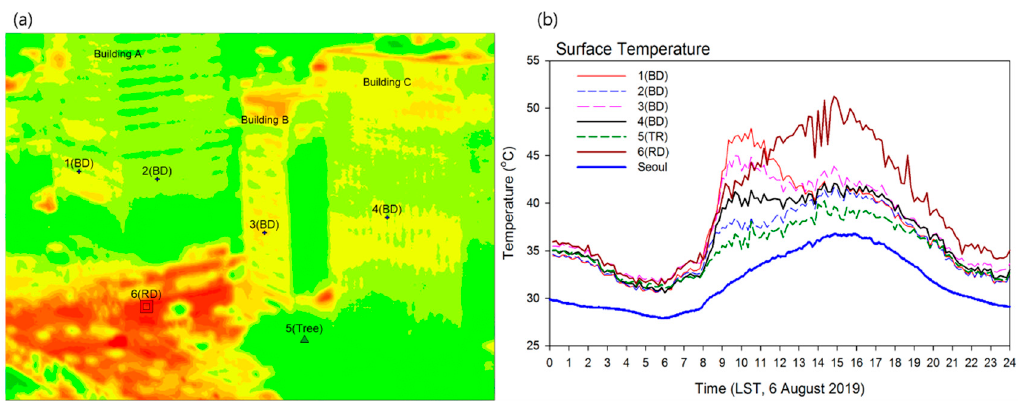
Figure 8. ( a ) Locations of 6 selected points, and ( b ) time series of surface temperature at the 6 selected points and the Seoul station on 6 August 2019.